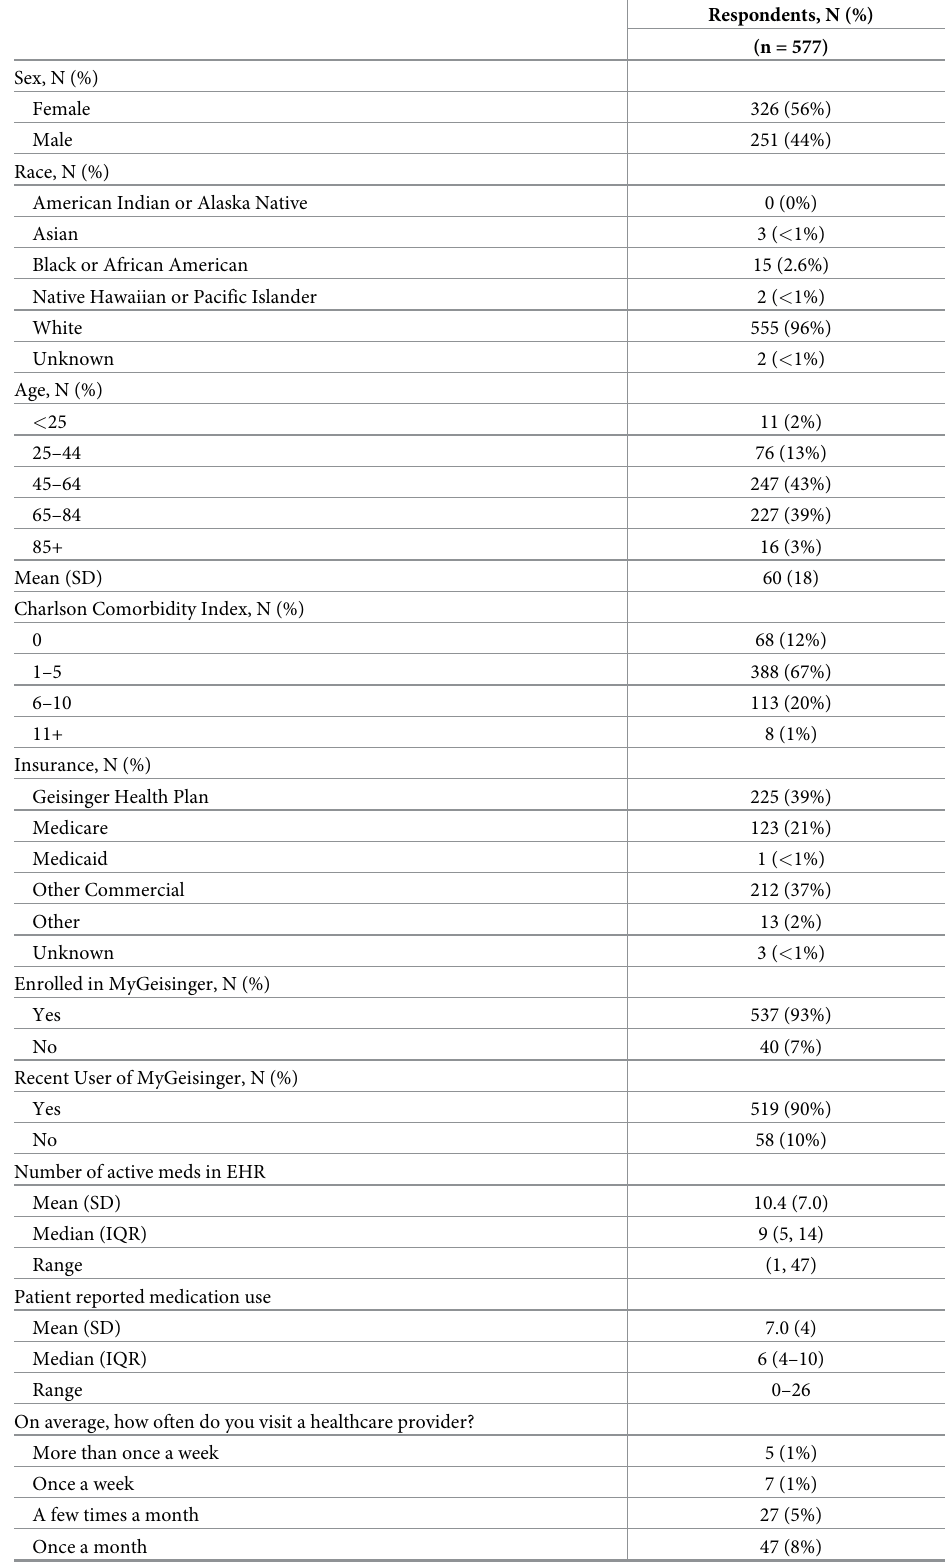
Table 2. Patient survey